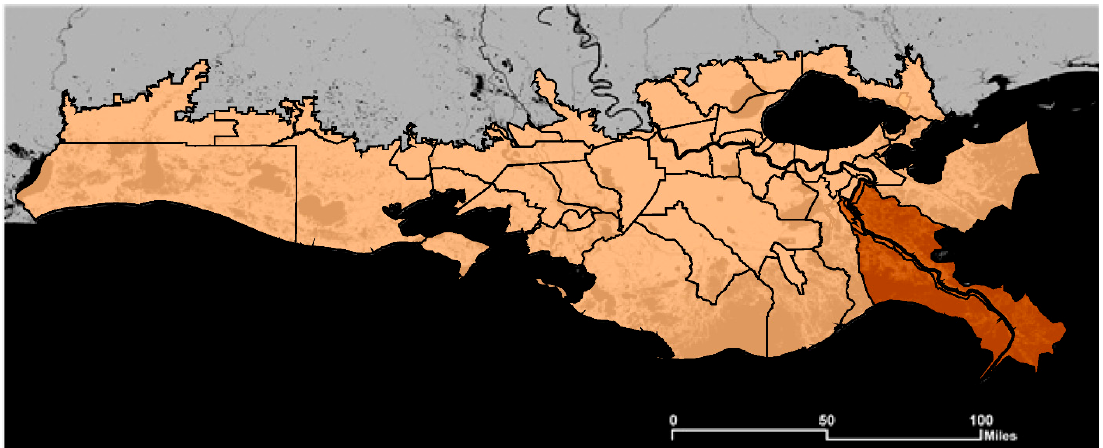
Figure 1. Study region in coastal Louisiana. Risk regions in Plaquemines Parish referenced in later results highlighted in